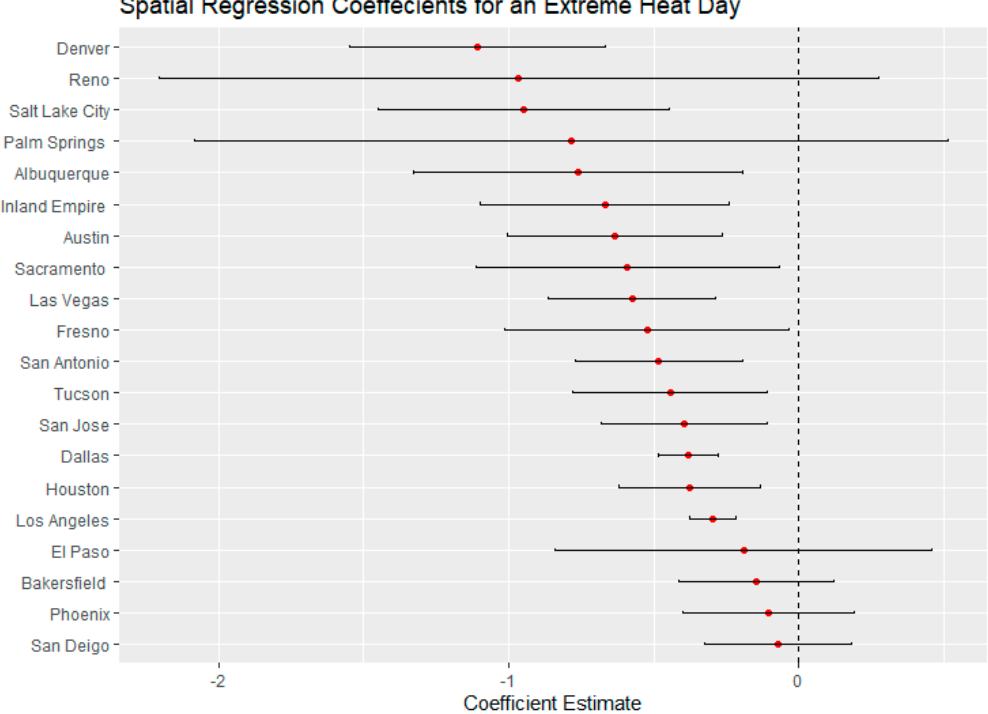
Figure 7. Spatial regression coefficients for Latinx populations during an average heat day in 20 Southwest metropolitan areas.